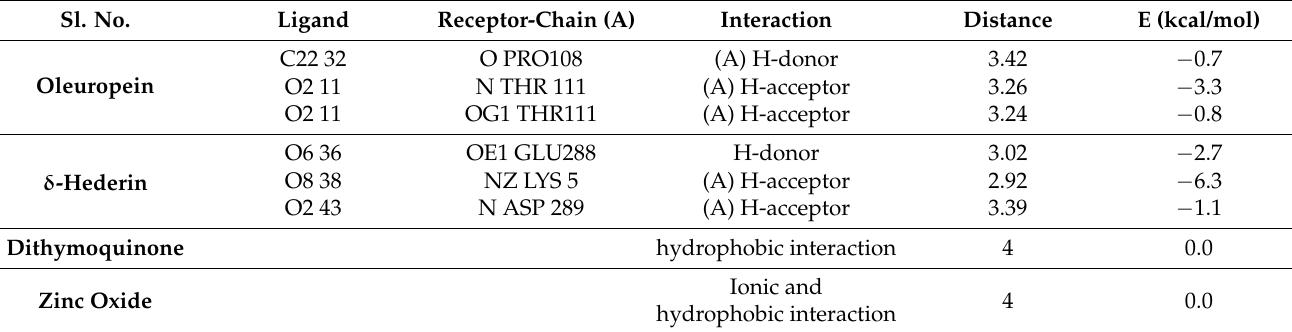
Table 3. Interactions and binding energies of ligands with SARS-CoV-2 3CL protease (PDB ID: